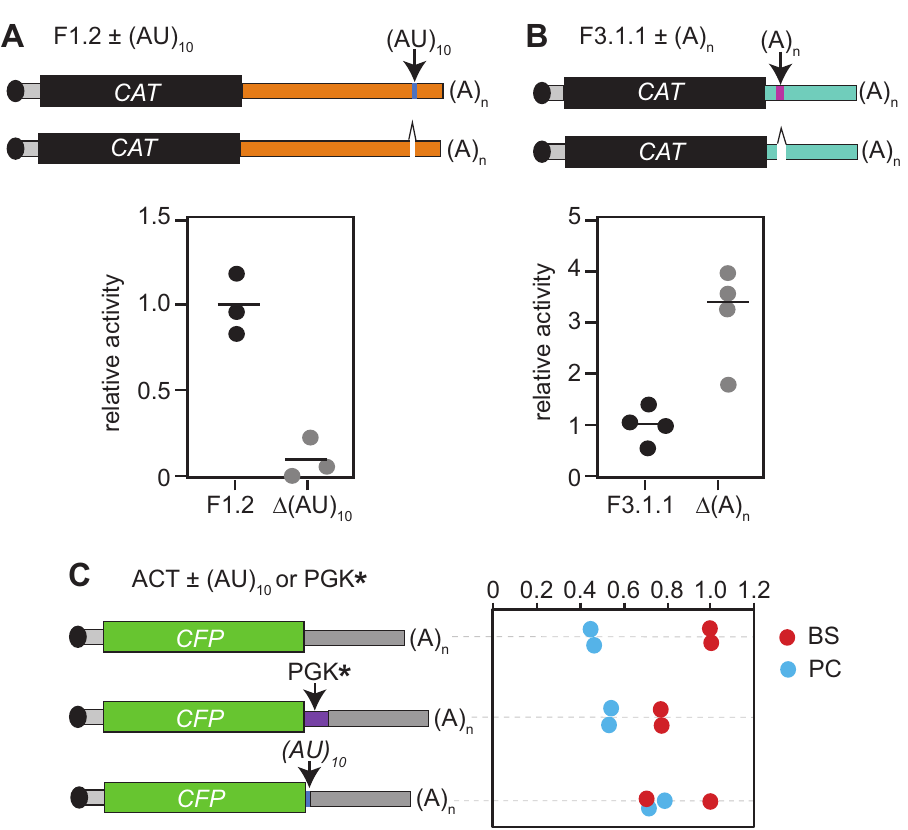
Fig 4. Analysis of specific sequences. A. Results for a CAT reporter plasmid containing RBP10 3’-UTR fragment 1.2 bearing (AU) 10 repeats and a mutated version without them. The average result for the fragment with the repeats is set to 1. B. As (A) but showing deletion of a poly (A) tract from fragment 3.1.1. C. Results for a CFP reporter plasmid containing the ACT 3’-UTR with either (AT) 10 or the PGKC � fragment inserted after the CFP coding region. The measurements are the averages of duplicate technical replicates for two independent populations, analysed with two different